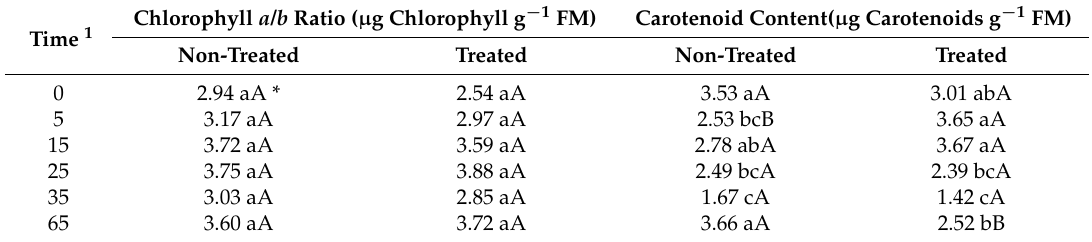
Table 2. Chlorophyll a/b ratio and total carotenoid content in the cultivar,